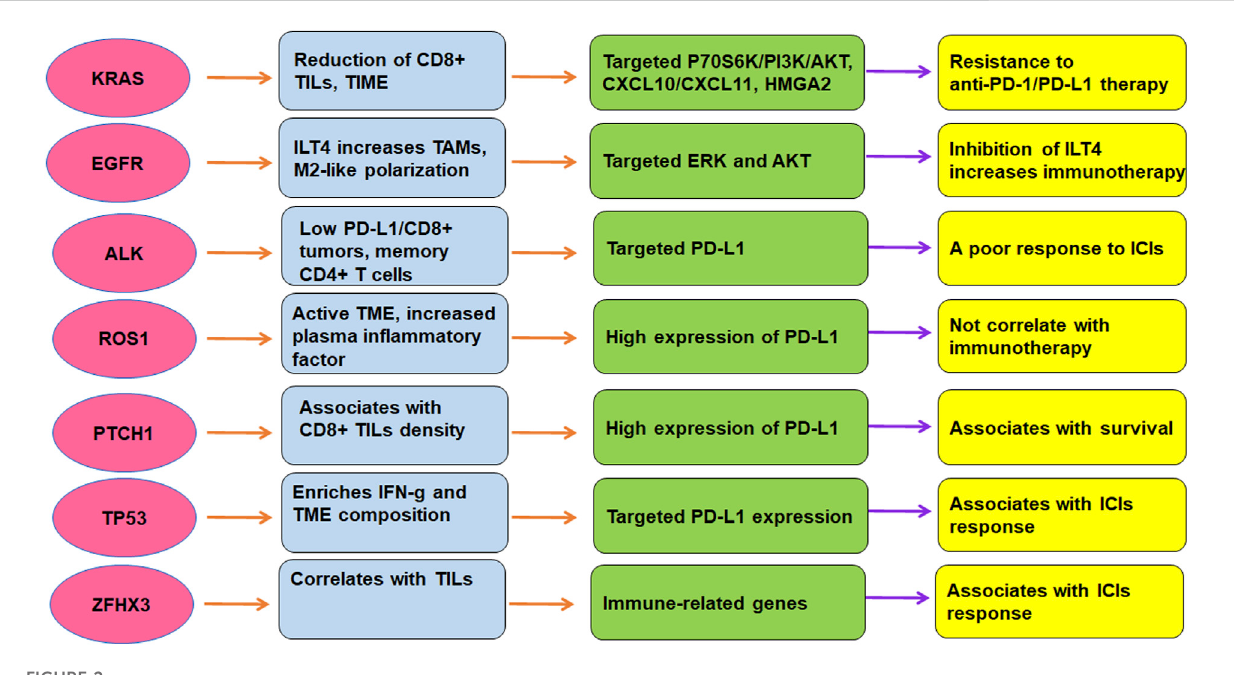
FIGURE 2 The role of gene mutations in regulation of TME and immunotherapy in lung cancer. The ef fi cacy of immunotherapy was regulated by driven gene mutations in lung cancer, including KRAS, TP53, EGFR, ALK, ROS1, ZFHX3, and